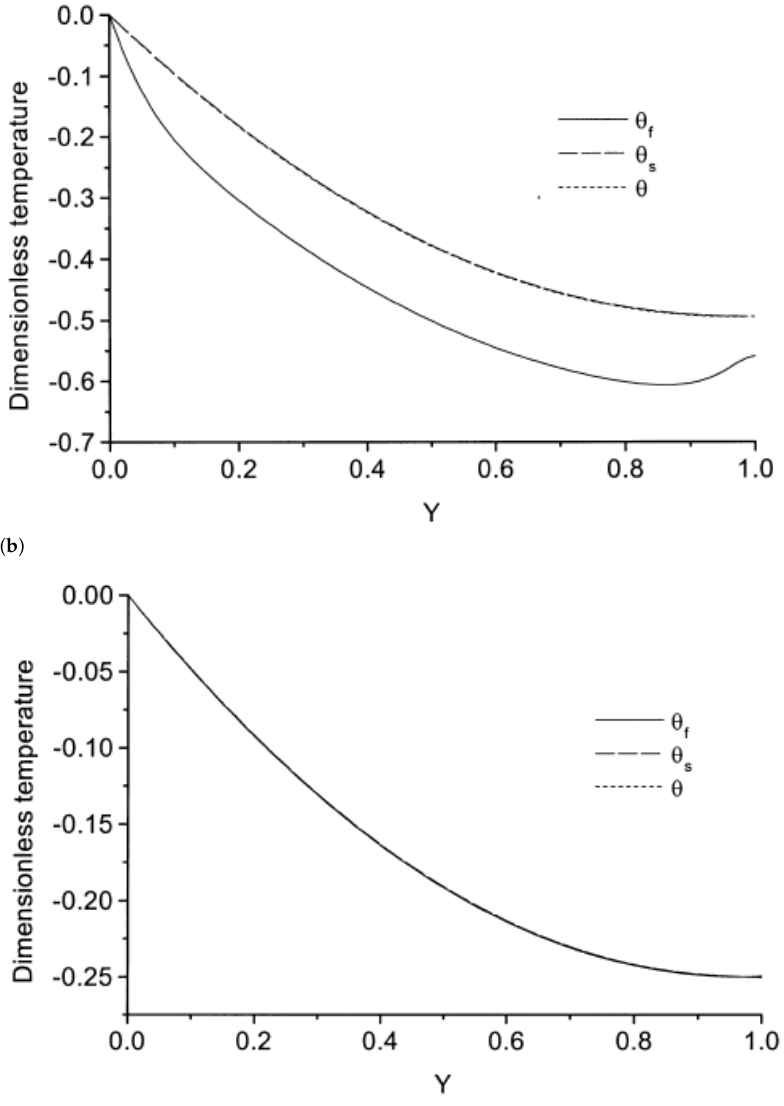
Figure 12. Distributions of fluid temperature ( θ f ), solid temperature ( θ s ), and average temperature ( θ ), using two-equation model, showing the effect of fluid/solid conductivity ratio for ( a ) C = 0.01 and ( b ) C = 1, at Da = 0.001, reported by Kim et al.